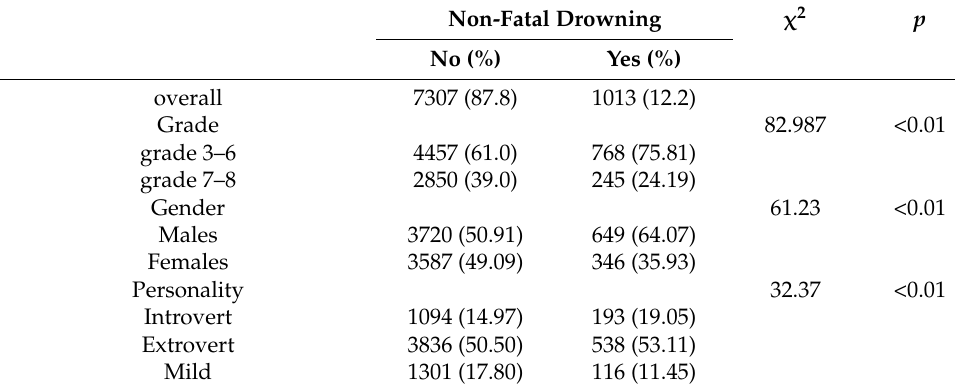
Table 1. Univariate analysis on the risk factors of drowning in